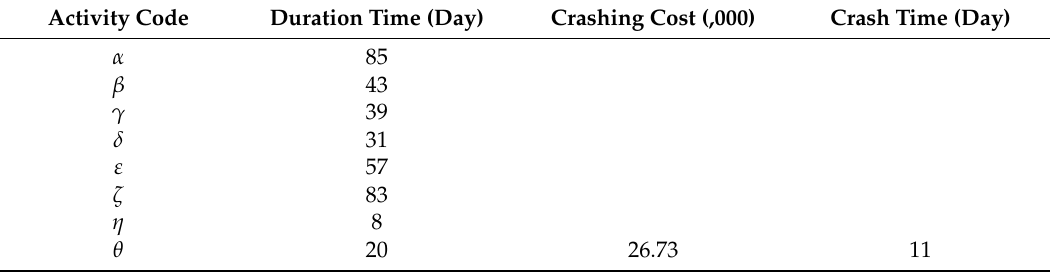
Table 6. Results of the fuzzy multiple weighted-objective linear programming